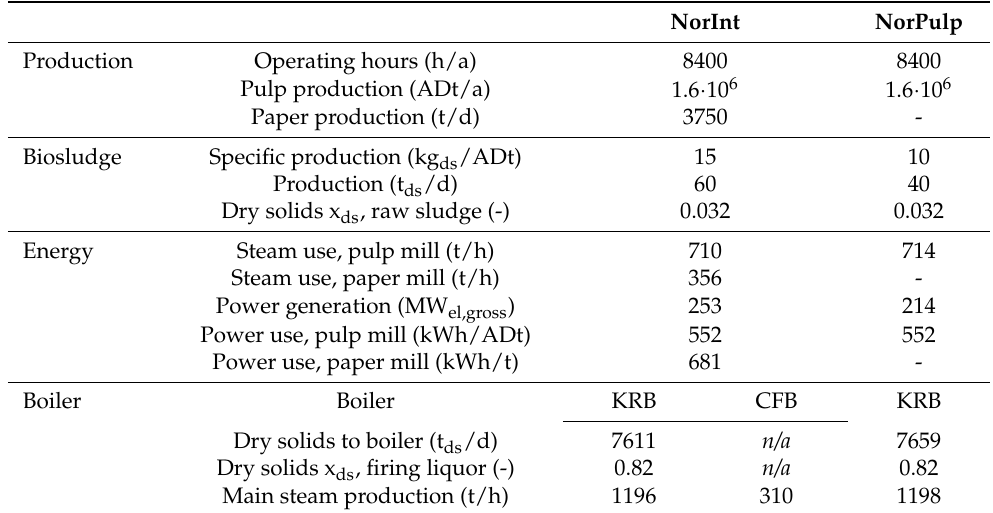
Table 1. Operating data of the considered